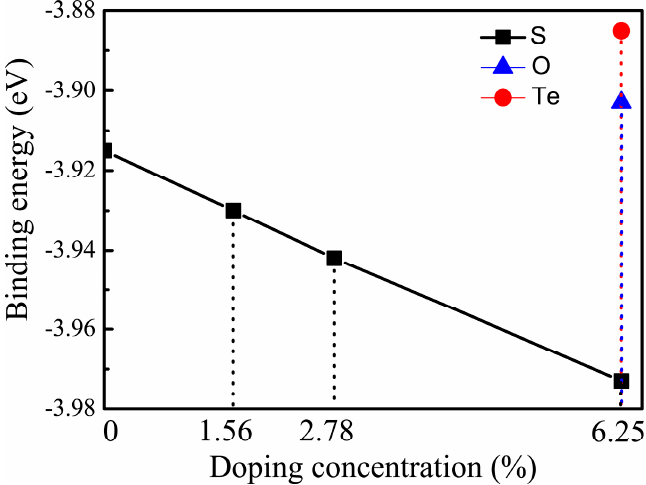
Figure 3. Variation of binding energy with doping elements and concentrations.